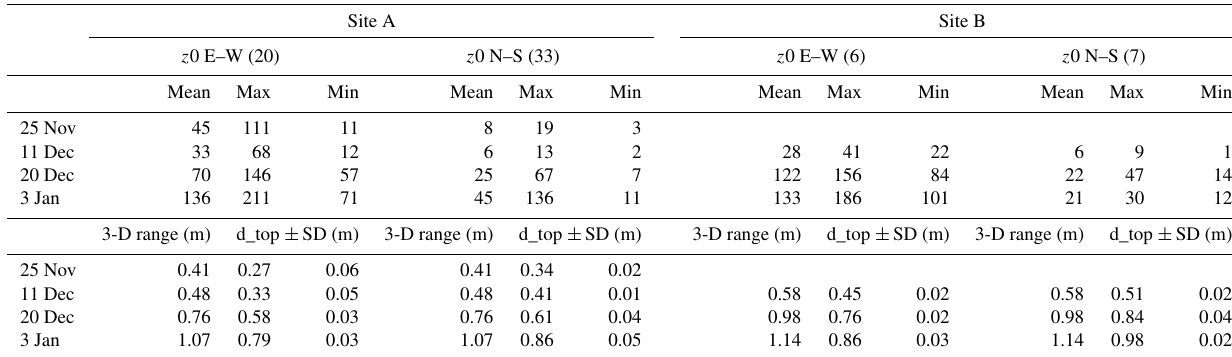
Figure 7. Three-dimensional z 0 computed for 10 ◦ aspect intervals for all detrended DSMs highlighting peak roughness that occurs in N–S airflow. Maximum values take h to be the detrended mesh elevation range, and minimum values take h to be twice the standard deviation of the detrended mesh. Table 3. Surface roughness ( z 0 ) computed according to Munro (1989) on detrended profiles longer than 1.5m, extracted at 0.10m intervals from the Kinect surface meshes at sites A and B for E–W impinging wind and N–S impinging wind. The number of profiles used for each wind direction is given in parentheses. The likely displacement of the zero velocity plane (d_top ± standard deviation) was computed as the mean of 2 / 3 h for all profiles and expressed as a distance from the top of the penitentes. The range of the detrended 3-D mesh (3-D range) provides a reference for the penetration depth of